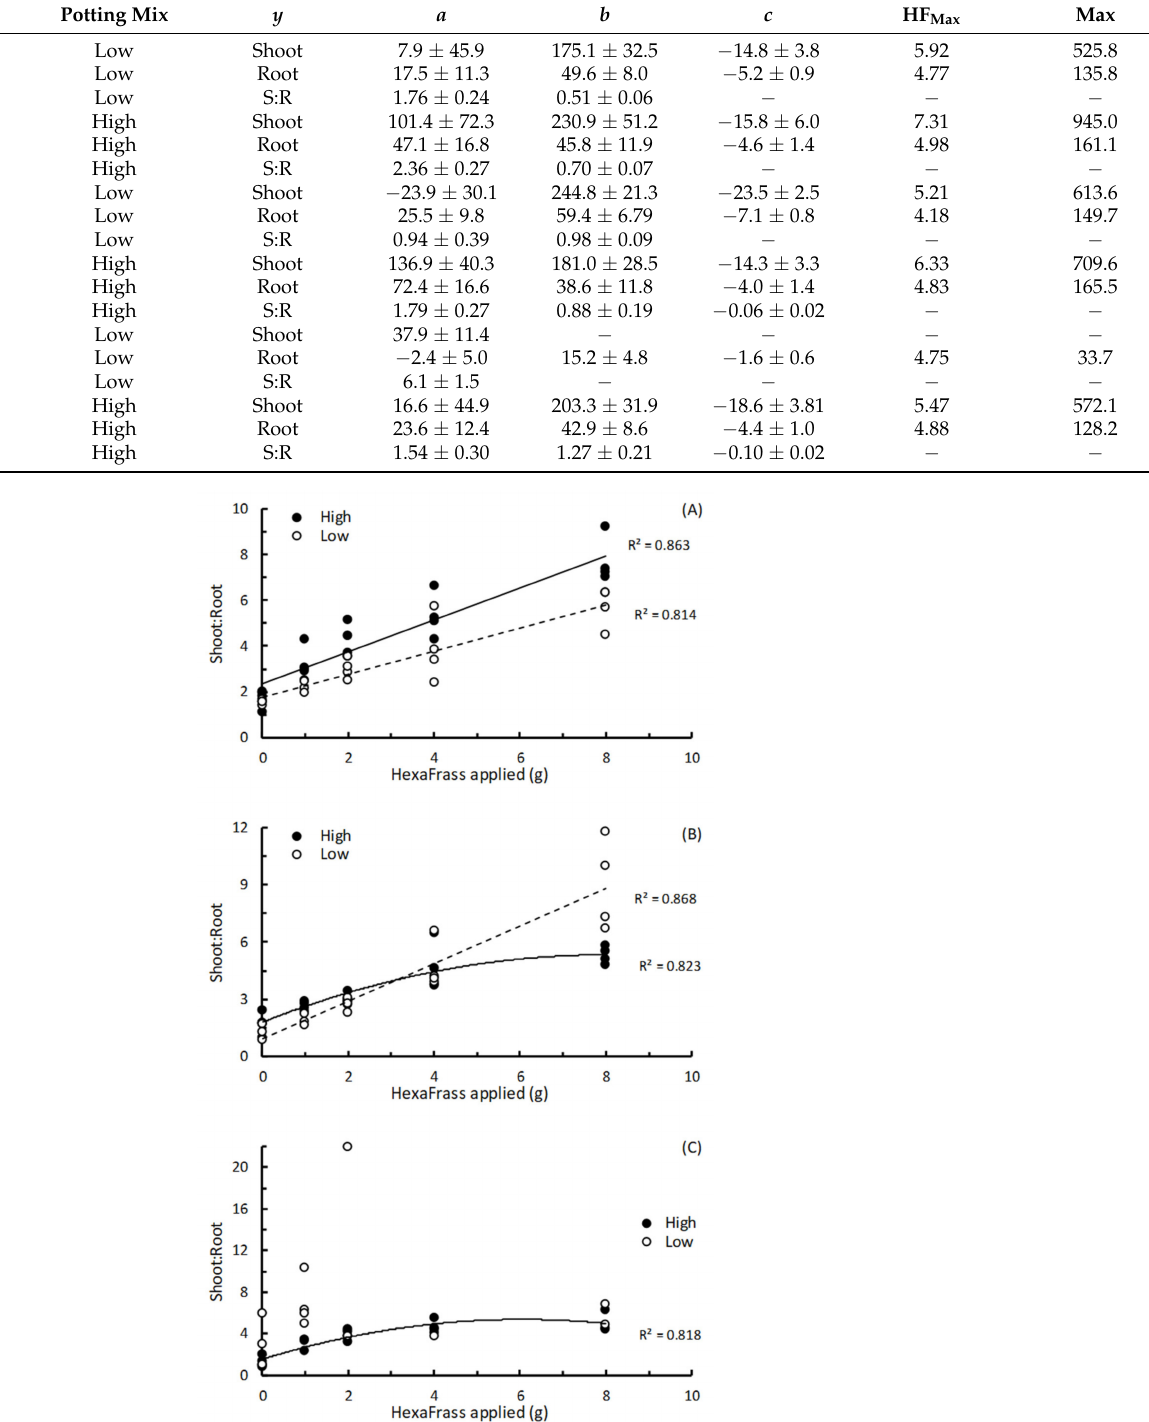
Figure 3. The relationships between shoot:root dry weight ratio and amount of HexaFrass™ (g) applied to high or low nutrient potting mix for ( A ) basil, ( B ) lettuce and ( C ) parsley. R 2 values produced from either linear regression or fitting polynomial order 2 regression